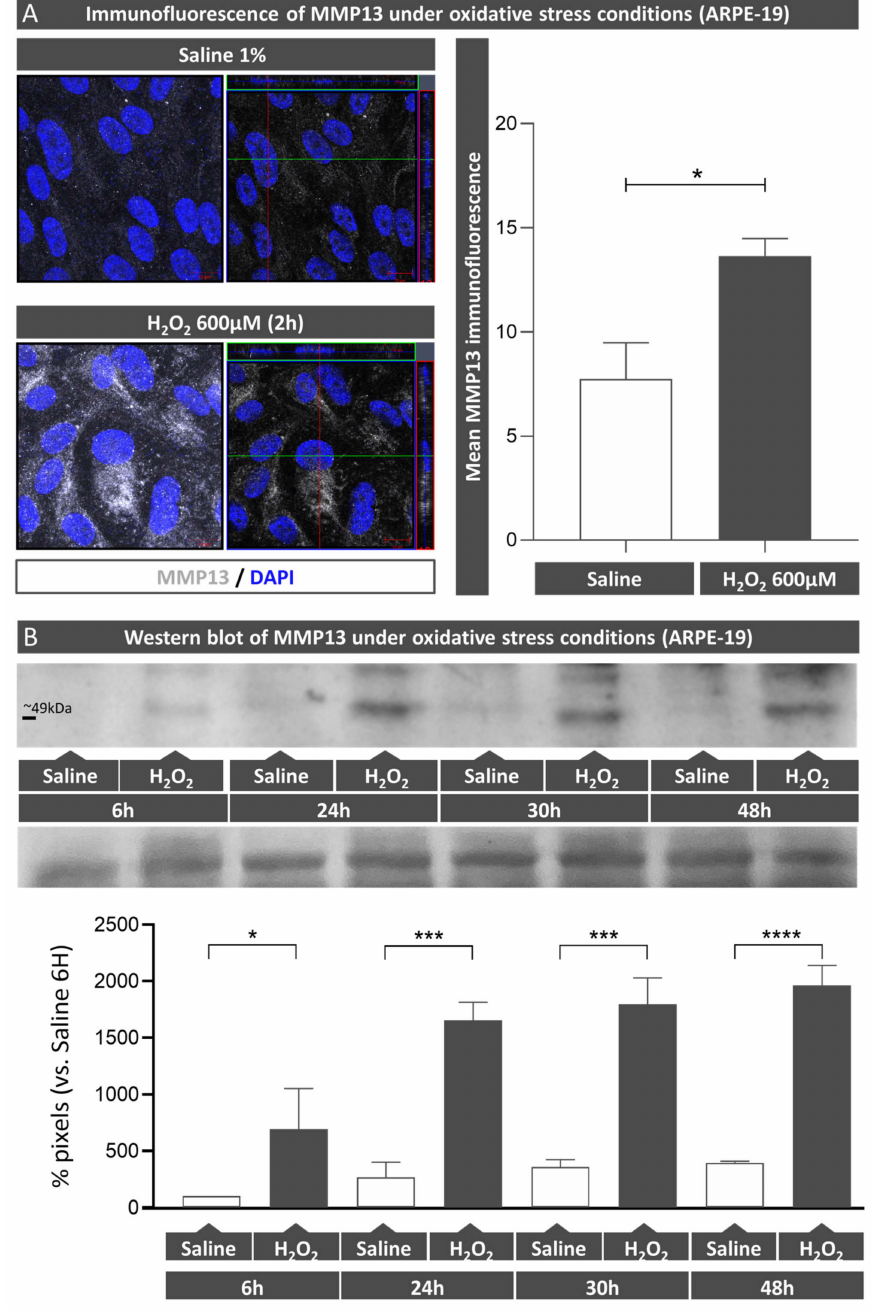
Figure 2. MMP13 localization and overexpression in ARPE-19 cells after oxidative stress induction. ( A ) Immunofluorescence of precursor and active MMP13 under basal conditions with 1% saline and under oxidative stress conditions (600 µ M H 2 O 2 for 2 h). The corresponding orthogonal view of the obtained z-stack is shown next to it. A significant increase in MMP13 expression is observed when subjected to oxidative stress. Mann–Whitney U; * p < 0.05 (n = 3). Scale bar: 10 µ m. Nuclei are labeled with DAPI (blue). ( B ) WB analysis of MMP13 in ARPE-19 cells exposed to H 2 O 2 600 µ M at different times (6, 24, 30, and 48 h) vs. saline control 6 h. Ponceau S red is shown below the WB image and